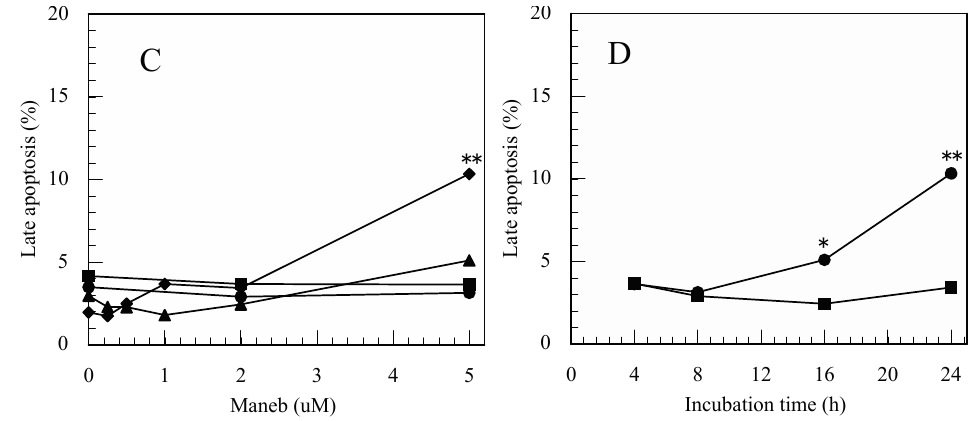
Figure 2. Maneb induced apoptosis in Jurkat T cells. ( A ): dose-dependent increases